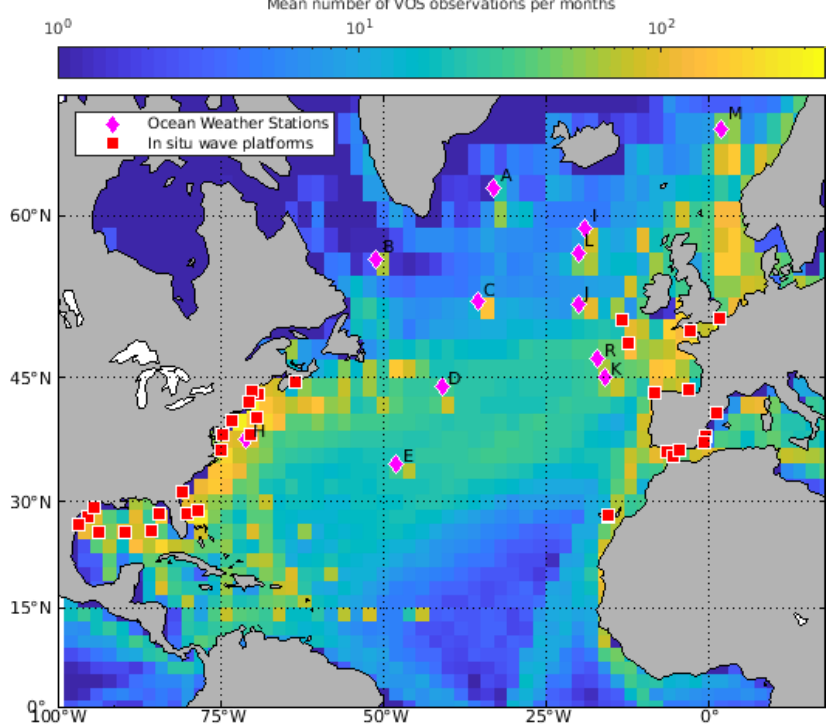
Figure 1. Map of historical ( > 25 years) wave measurements in the North